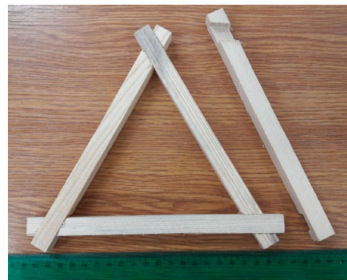
Figure 6. The beams of triangular crib with special notches.